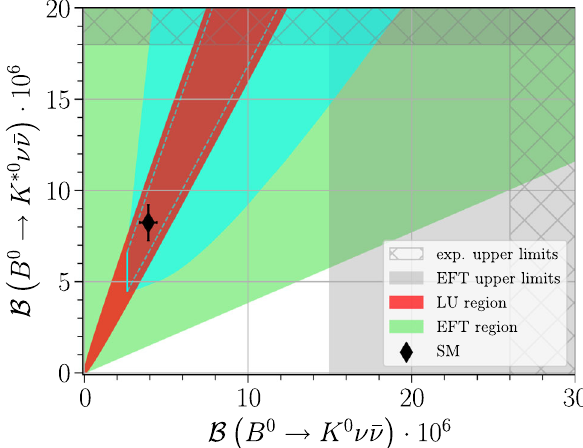
with uncertainties (black) from (29). The red region represents the LU region (25) at 1 σ , and it is mainly dominated from form factor uncer- tainties. The green region represents the validity of the EFT framework, given by Eq. (18). Cyan region represents cLFC region for a single species, in particular (cid:4) = τ , assuming a bound on B ( B 0 s → τ + τ − ) (cid:2) 10 − 6 . Dashed cyan lines represent the cLFC region for (cid:4) = μ , see main